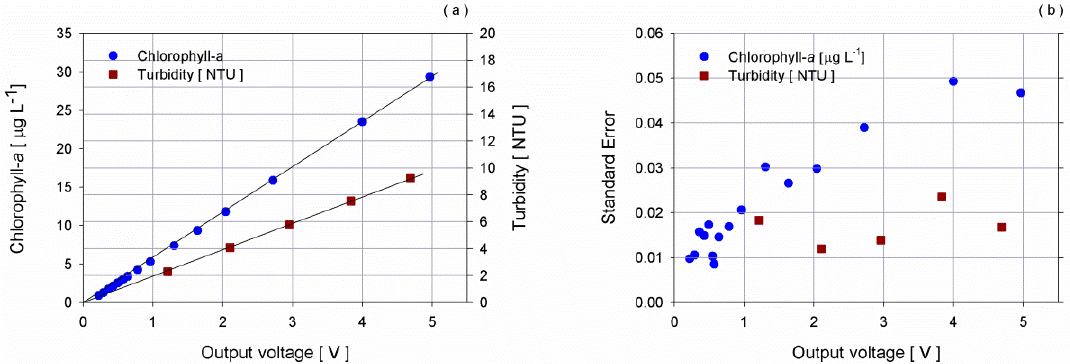
Figure 6. ( a ) Responses of fluorescence and turbidity sensor s/n 2776 and ( b ) corresponding standard error as the concentration of Chlorella (dot) and Formazine (square) increases.